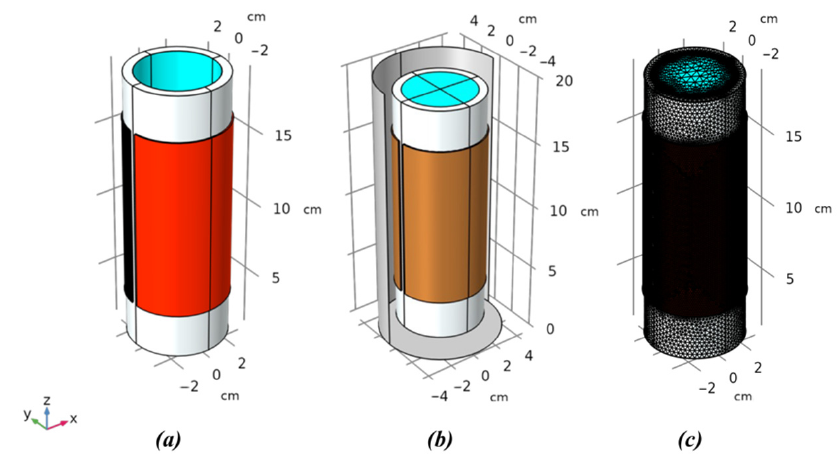
Figure 7. Cross-section diagram of the simulated capacitance-based sensor in the middle of the elec- trode.